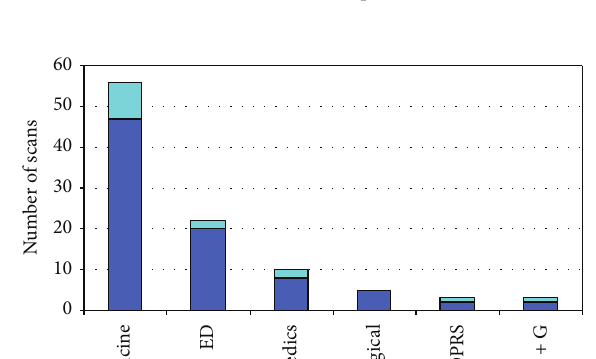
Figure 2: Mean CTPAs per month.